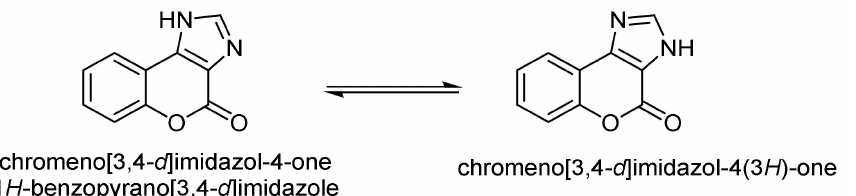
Figure 2. The common isomer of fused